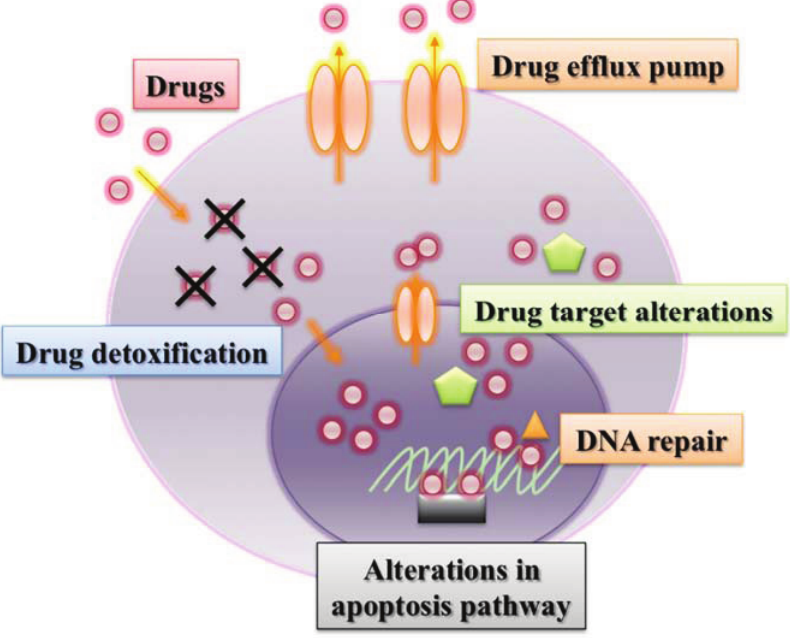
Figure 1. Representative molecular mechanisms of drug